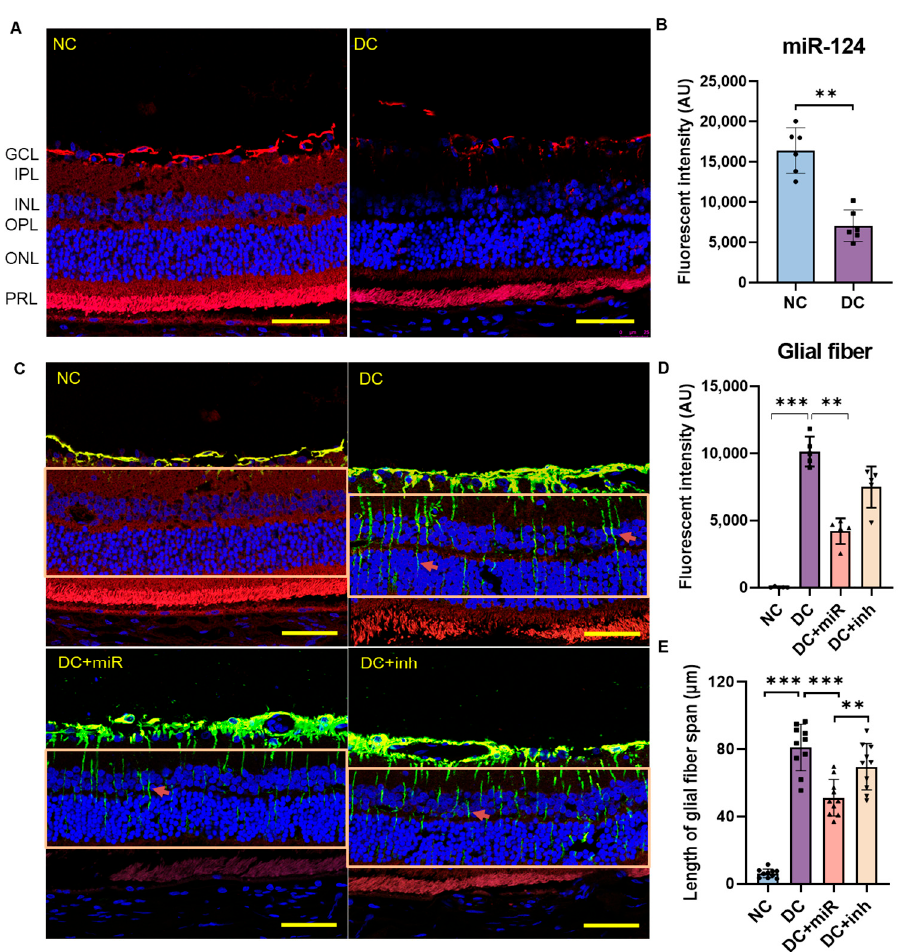
Figure 2. The expression of miR-124 in rat retinae and its effect on the activation of Müller glia in diabetic retinae. ( A ) Representative images of ISH probed with miR-124 (red) on the paraffin-embedded retinal vertical sections of 24-week-old healthy Wistar rats (NC) and diabetic Wistar rats (DC). GCL: ganglion cell layer; IPL: inner plexiform layer; INL: inner nuclear layer; OPL: outer plexiform layer; ONL: outer nuclear layer; PRL: photoreceptor layer. ( B ) Quantification of miR-124 ISH fluorescent intensity in ( A ) using Image J/Fiji software version 1.53c. Data are exhibited as mean ± SD, n = 6, ** p < 0.01 ( t -test). ( C ) Representative images of ISH probed with miR-124 in combination with immunofluorescence staining of GFAP performed on the retinae of non-diabetic control rats (NC), diabetic rats (DC), DC treated with miR-124 (DC+miR), or DC treated with miR-124 inhibitor (DC+inh). The miR-124 probe was labeled with Alexa Fluor 555 (red), GFAP was labeled with Alexa Fluor 488 (green), and nuclei were labeled with DRAQ5 TM (blue). ( D ) Quantification of GFAP fluorescence in Müller glial radial fibers (indicated with arrows) within marked rectangular areas was performed using Image J/Fiji software. ( E ) Quantification of the length of endfeet of Müller glia down to the deep retinal layer performed using Image J/Fiji software. Data are exhibited as mean ± SD, n = 5–10, ** p < 0.01, *** p < 0.001 (one ‐ way ANOVA with Tukey’s multiple comparisons test). The images were taken with the Leica confocal microscope SP8, scale bar = 50 μ m.